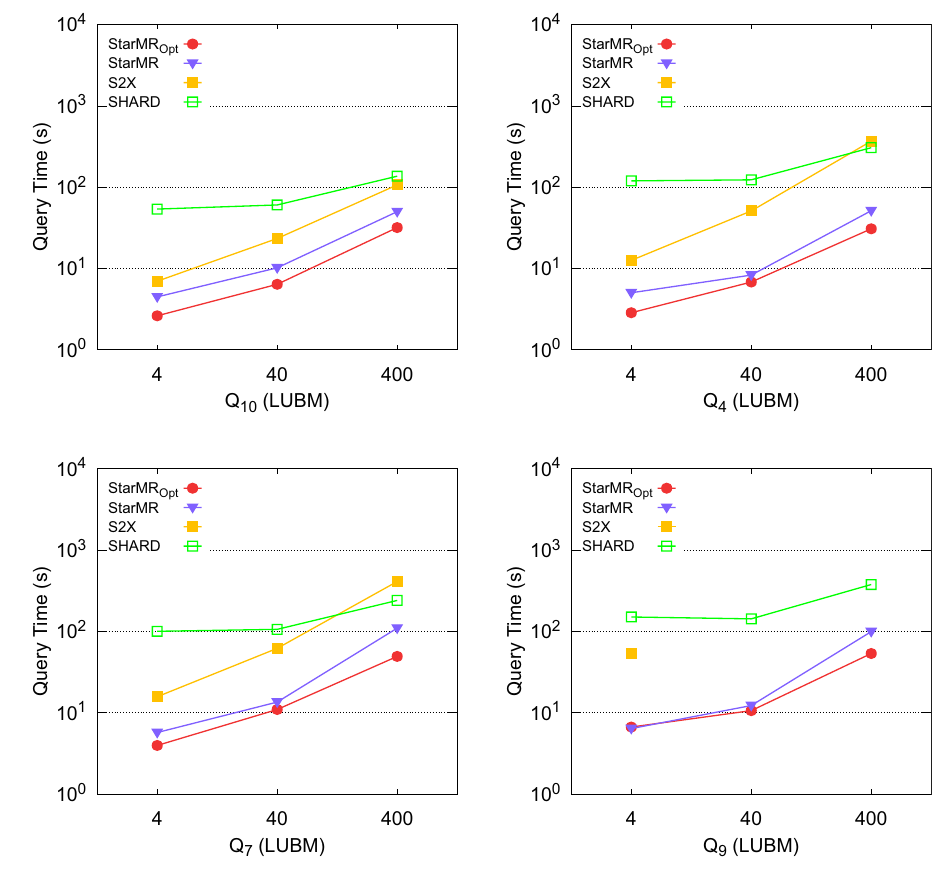
Fig. 9 Scalability on LUBM